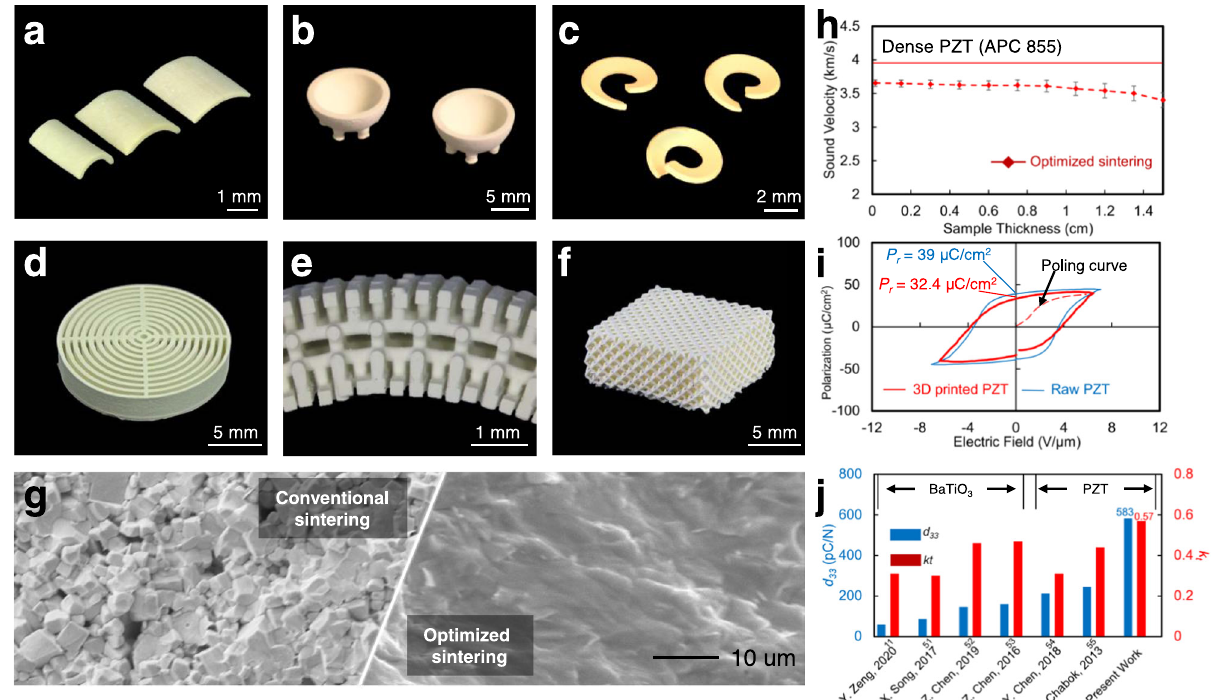
Fig. 2 | PZT free-form fabrication and piezoelectric performance of the as- fabricated piezoelectric elements. a Micro-curved stave elements with different curvatures. b Hemisphere elements used in a general ultrasound transducer for medicalimagingandnondestructivetesting. c Helicalelementforgeneratingspiral acoustic fi elds for ultrasound manipulation. d Cylindrical transducer element with multiple concentric annular layers. e Lattice sensor element for low-frequency (<100kHz) ultrasound. f Force sensor element with ultrahigh sensitivity. g SEM